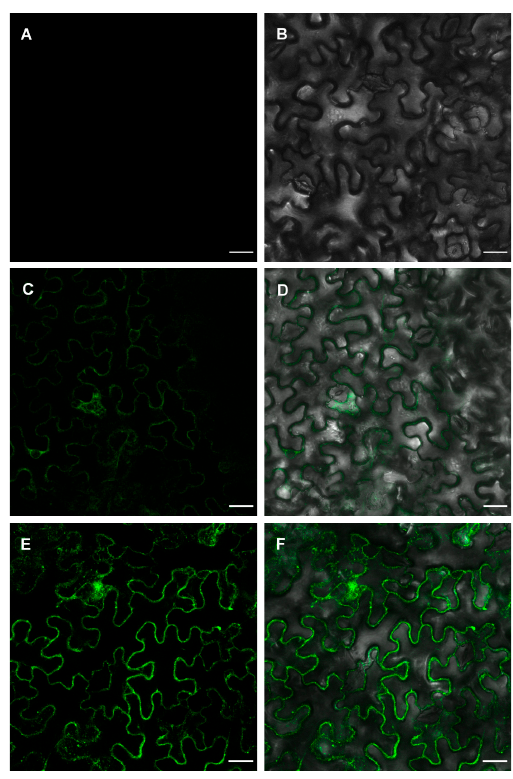
Figure 3. Transient expression of ZosmaNRT2 and ZosmaNAR2 in N. benthamiana leaves using Agrobacterium infection. Fluorescence ( A ) and merge of fluorescence and bright field ( B ) images of epidermal leaf cells transiently transformed with empty vector pGWB1 used as the control. Fluorescence ( C ) and merge of fluorescence and bright field ( D ) images of epidermal leaf cells transiently transformed with 35S::ZosmaNRT2-GFP . Fluorescence ( E ) and merge of fluorescence and bright field ( F ) images of epidermal leaf cells transiently cotransformed with 35S::ZosmaNRT2-GFP and 35S::ZosmaNAR2 . Each confocal image is a representative picture of ten independent assays. Bars: 25 µ m. for ZosmaNRT2 localization and its stabilization at the plasma membrane by NAR2, which fits the function of ZosmaNRT2 as a NO 3 − transporter.